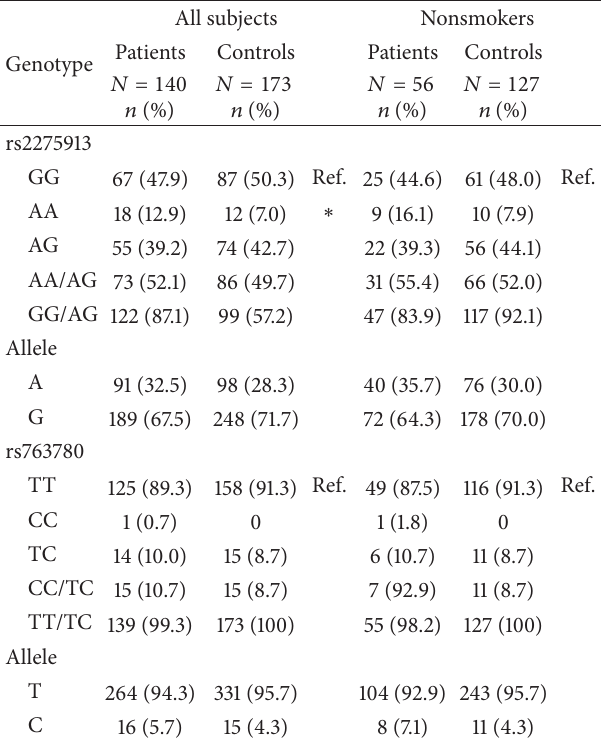
Table 2: Genotypes and allele distribution of IL17A rs2275913 and IL17F rs763780 in the patients with chronic periodontitis and controls from Southern Brazil.